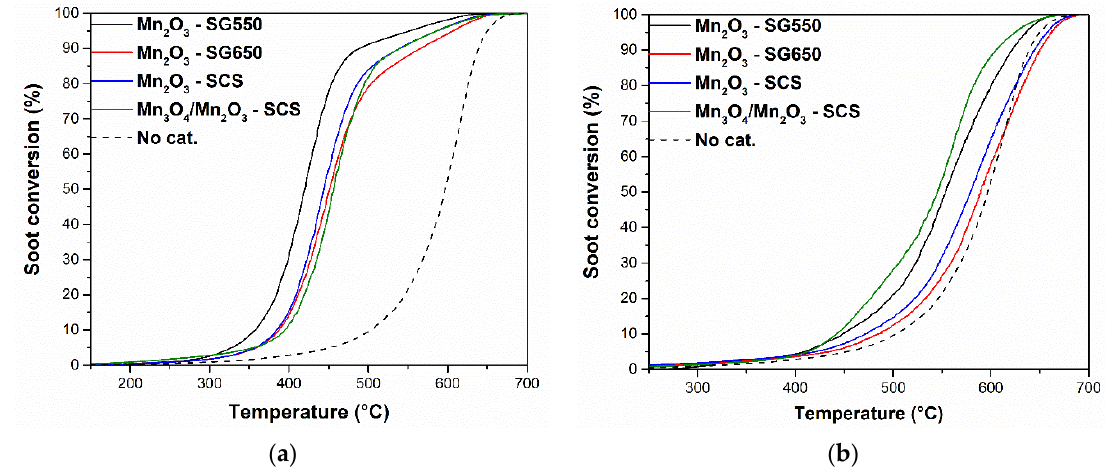
Figure 8. Catalytic conversion of carbon soot as a function of the temperature in ( a ) “tight” and ( b ) “loose” contact conditions.